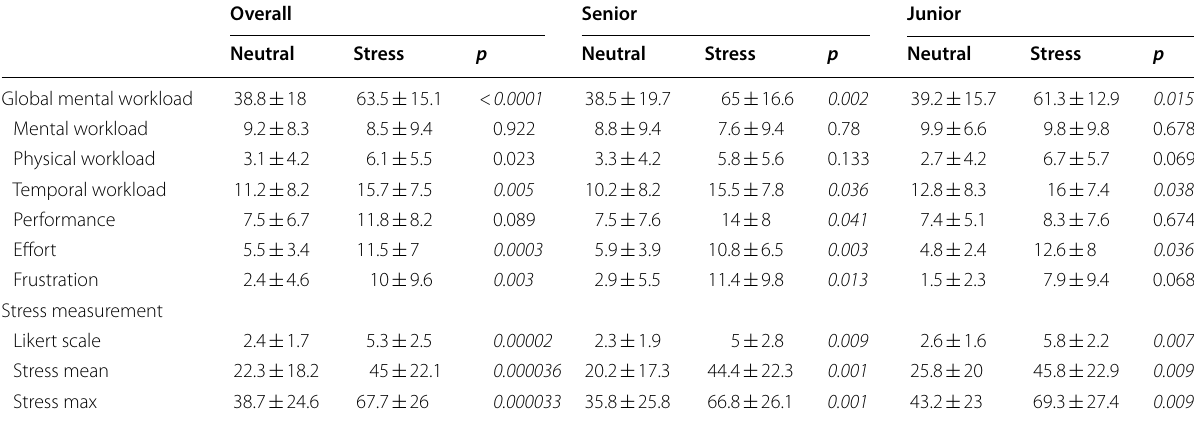
Table 3 Psycho-cognitive and subjective emotional excitation assessment